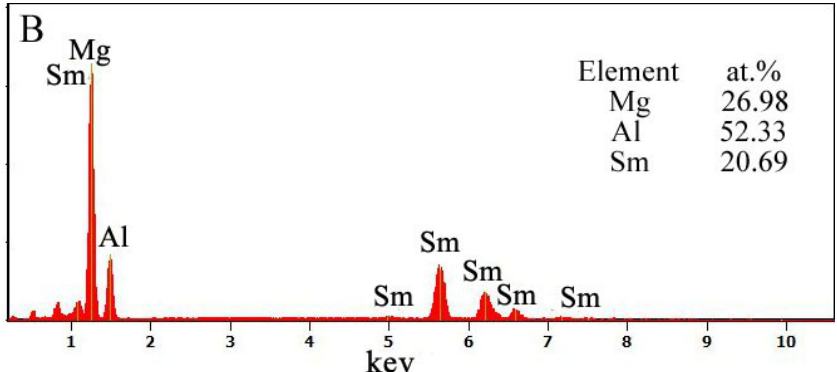
Figure 3. Energy dispersive spectroscopy (EDS) images: ( A ) the Al-Mn phase in AZ91 and ( B ) the Sm-rich in AZ91-0.5Sm magnesium alloy.